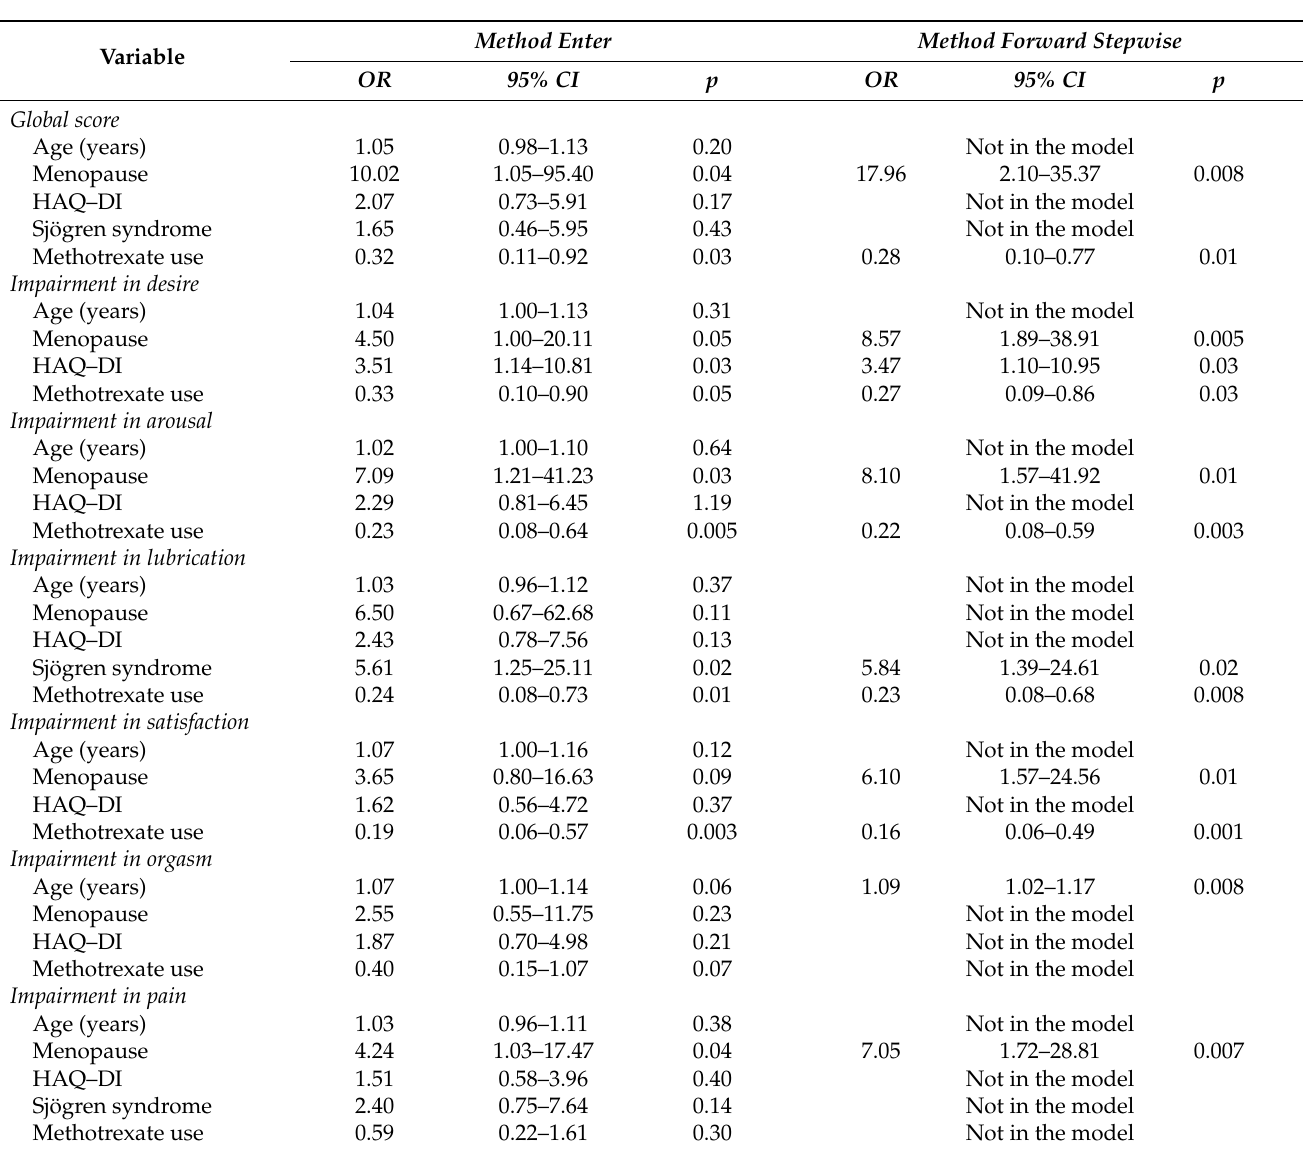
Table 5. Adjusted analysis of factors associated with the presence of sexual dysfunction in rheuma- toid